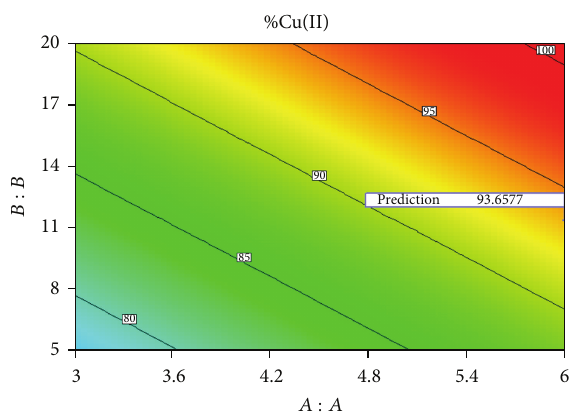
Figure 8: Prediction of removal efficiency with optimized parame-